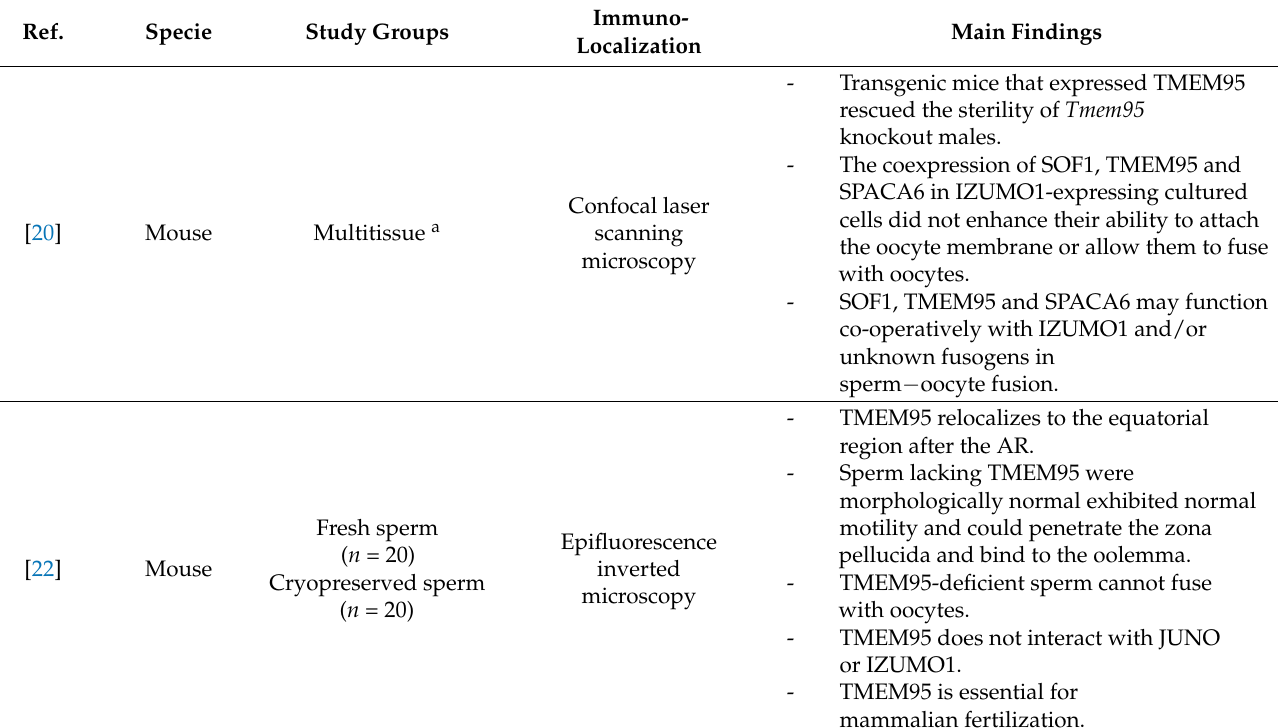
Table 1. Articles studying TMEM95 in different